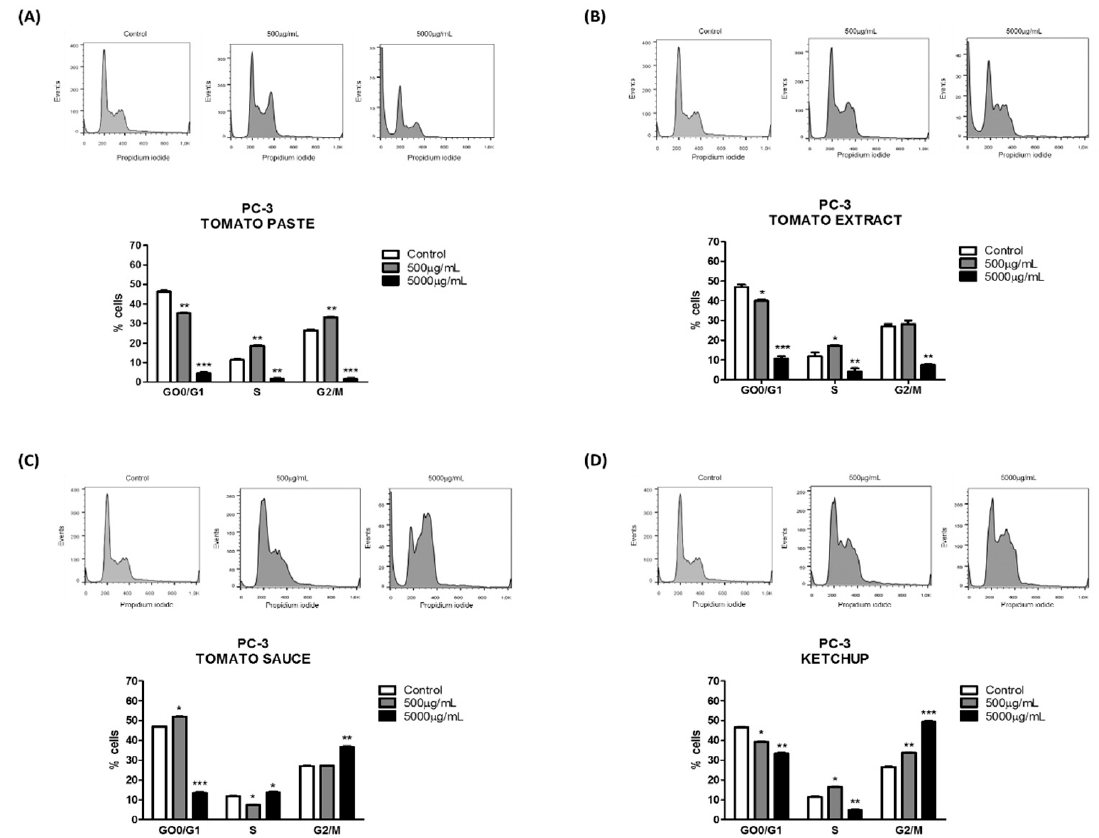
Figure 4. Effect of lycopene obtained of tomato paste ( A ), tomato extract ( B ), tomato sauce ( C ), and ketchup ( D ) on PC-3 cell cycle after 96 h of exposure. The results are expressed as mean ± error standard and significant differences between untreated cells (Control) and those treated with lycopene (500 and 5000 μ g/mL) were compared by 1-way ANOVA followed by Tukey’s multiple comparison post-hoc test. * p < 0.05; ** p < 0.01; *** p < 0.001.